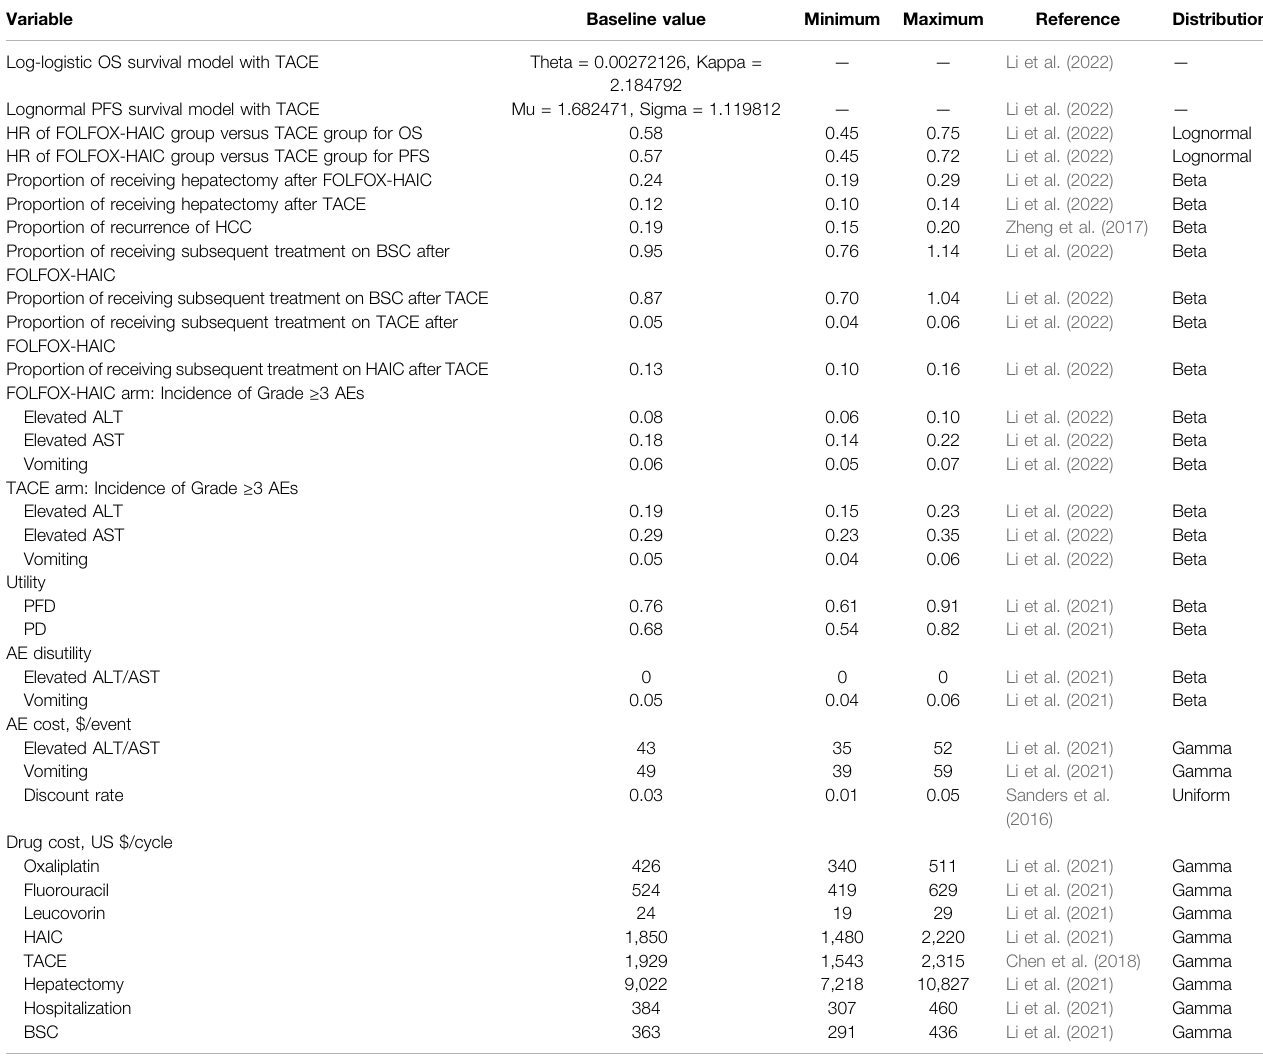
TABLE 1 | Parameters for the cost-effectiveness model.